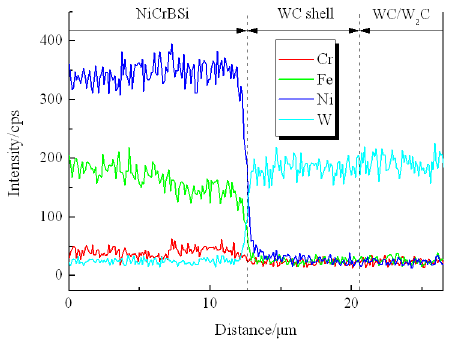
Figure 9. EDS line scan from NiCrBSi to the modified CTC P .